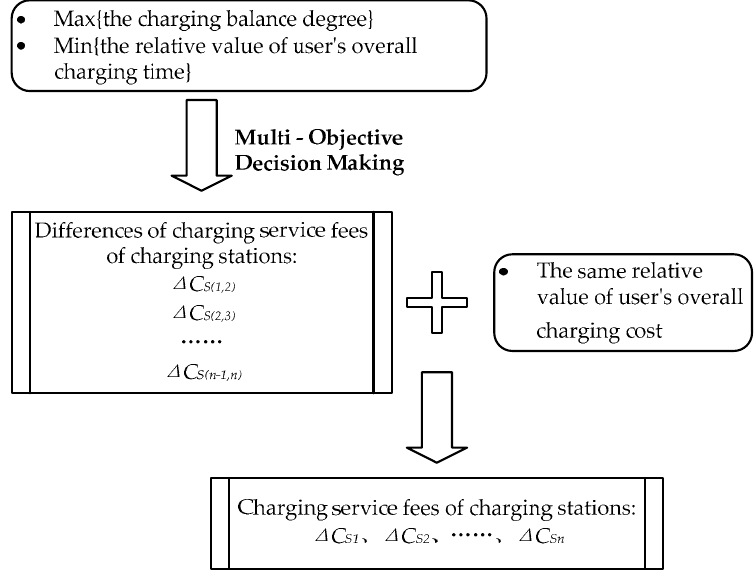
Figure 1. Flow chart of strategy devised for EV charging fees.